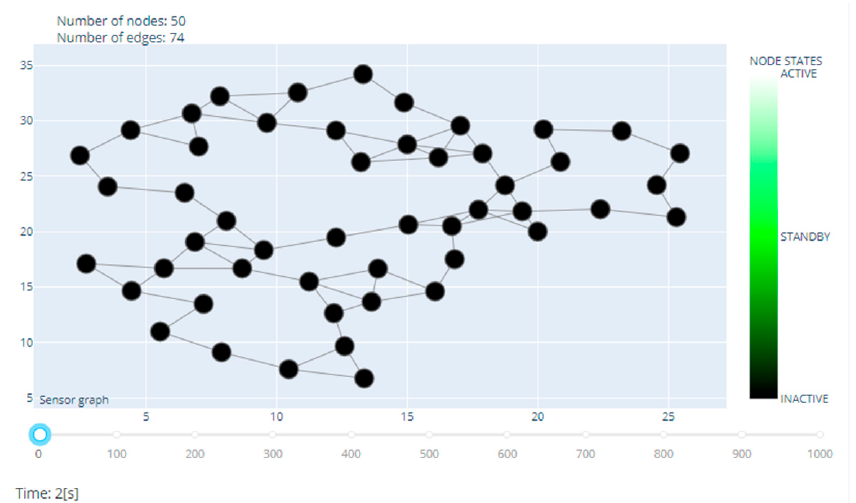
Figure 4. An example of the structure of a simulated sensor network.